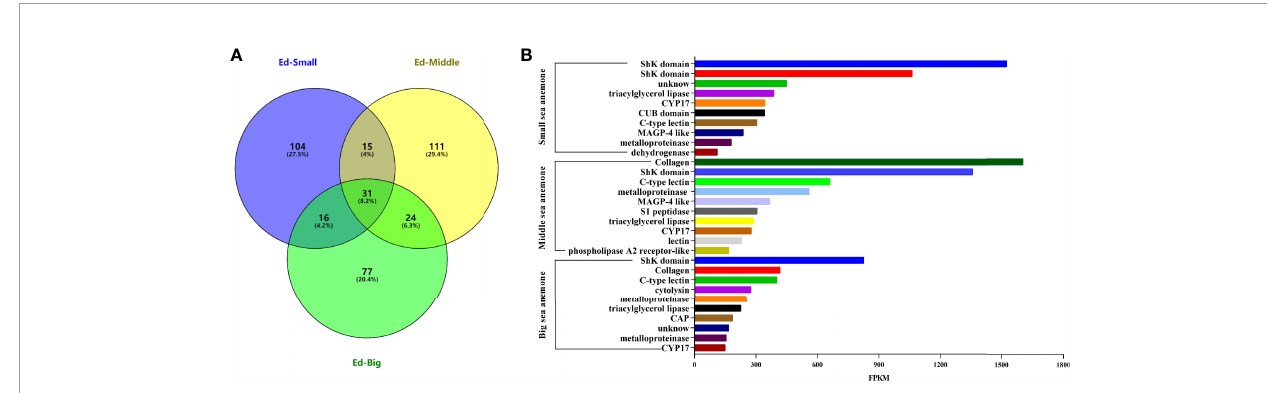
FIGURE 2 | Comparison of protein as well as peptide toxins transcripts from various Exaiptasia diaphana developmental stages. (A) Relationship of the putative protein and peptide toxins from Ed-Small, Ed-Middle and Ed-Big datasets of Exaiptasia diaphana . (B) Ten most highly transcribed protein and peptide transcripts from various Exaiptasia diaphana developmental stages.